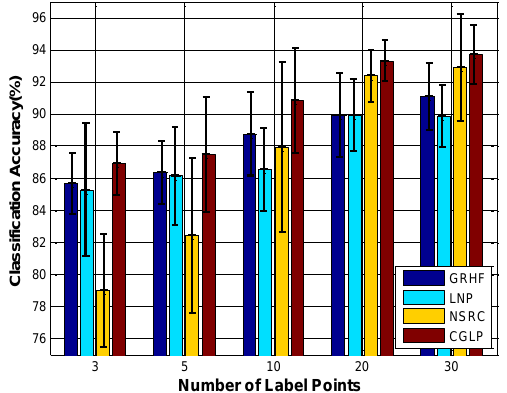
Figure 1 Classification results by different methods over Classes 3 and Classes 6 of BOT